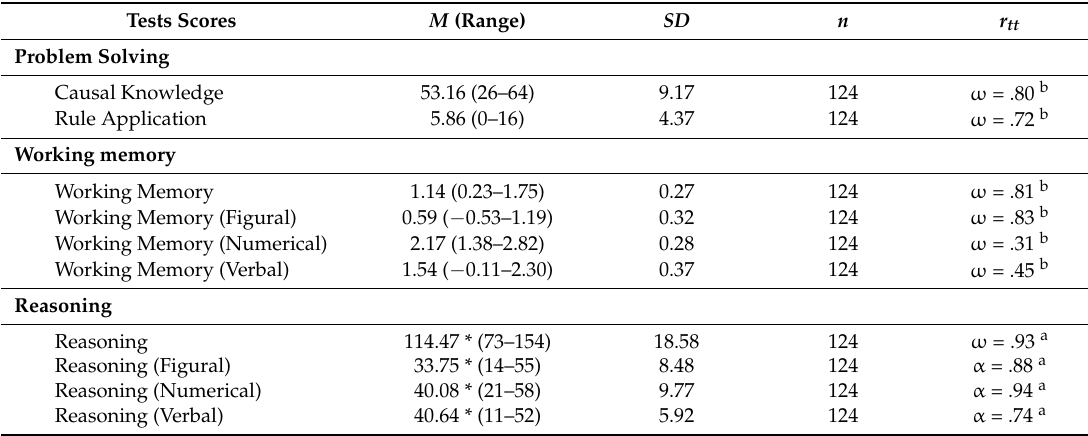
Table 2. Means, range, standard deviations, sample sizes, and reliabilities of the raw test